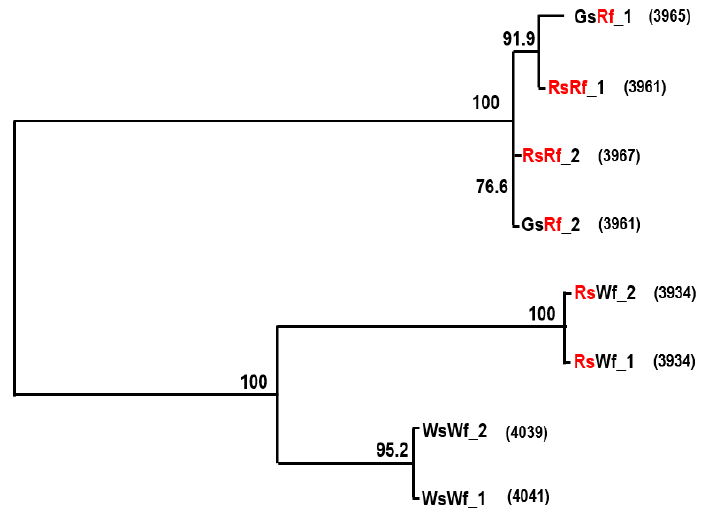
Figure 4. Phylogenetic relationship among RsTT8 alleles. Numbers in parenthesis indicate nucleotides of each allele.